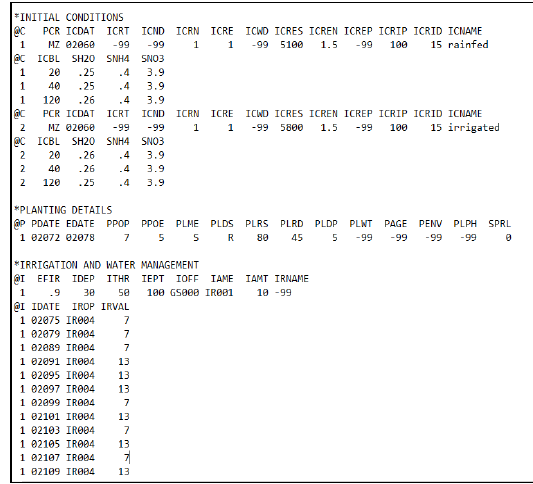
Figure 6. Management data in DSSAT format